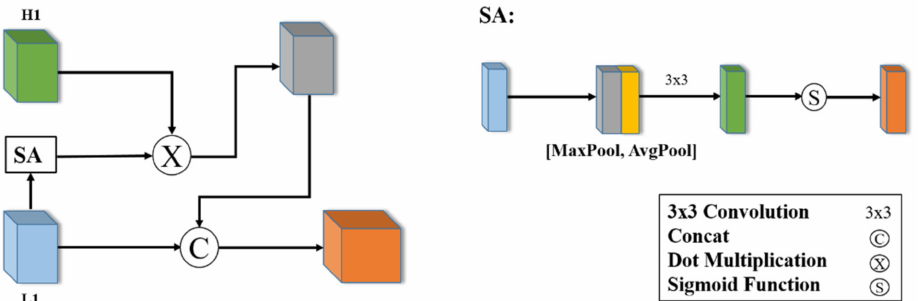
Figure 4. Detailed illustration of the refinement fusion module (RFM). In order to better integrate the high-level (H1) and low-level (L1) features, we introduced a spatial attention (SA) mechanism. By focusing on the spatial attention of the high-level features, we reduced the cluttered background influence in the low-level